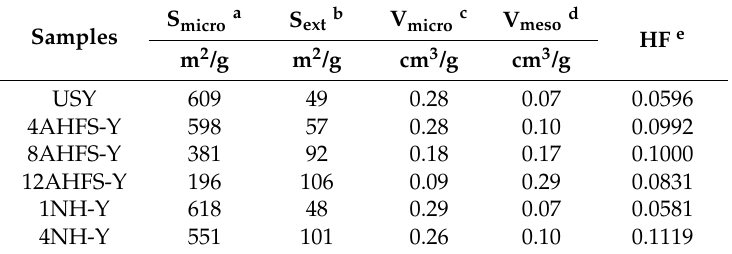
Table 3. The surface area and pore volume data of all the Y-type zeolites.